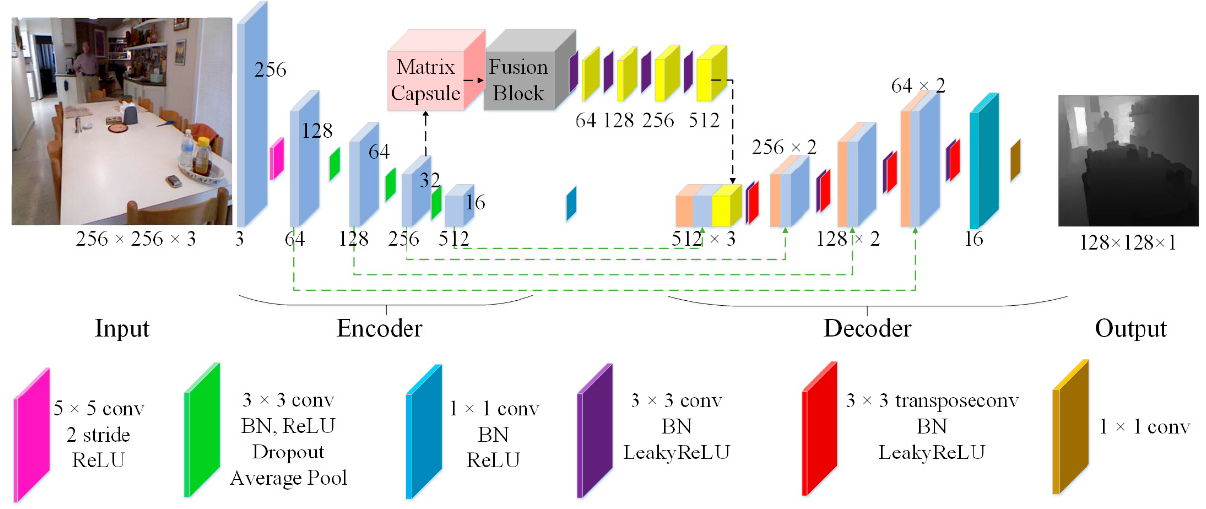
Figure 1. Architecture of the CNNaspule network.